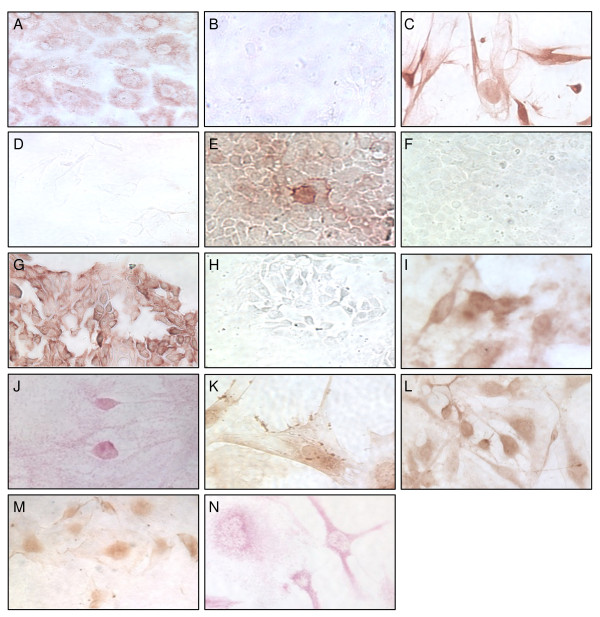
IHC for growth factor receptors on different CC cell lines. Immunostaining of EGFR on EGI-1 (A), HuH28 (C), OZ (E) and TFK-1 (G) with the according isotype staining (B, D, F and H). Immunostaining of HGFR (I), IGF1R (J), IGF2R (K), VEGFR1 (L), VEGFR2 (M) and VEGFR3 (N). IHC revealed expression of the growth factor receptors tested in all human CC cell lines. ABC procedure (A-I, K-M) and APAAP method (J and N). Original magnification × 200.